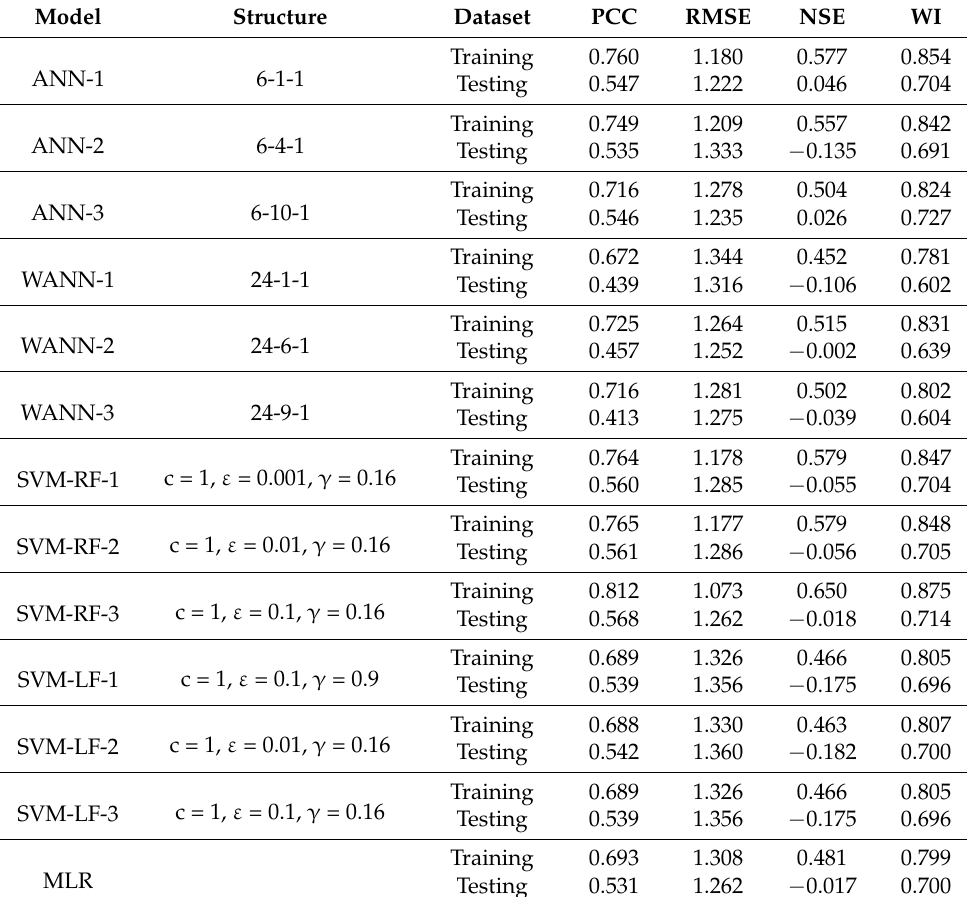
Table 5. Results for ANN, WANN, SVM-RF, SVM-LF, and MLR during training and testing period for Scenario 2 (70–30: